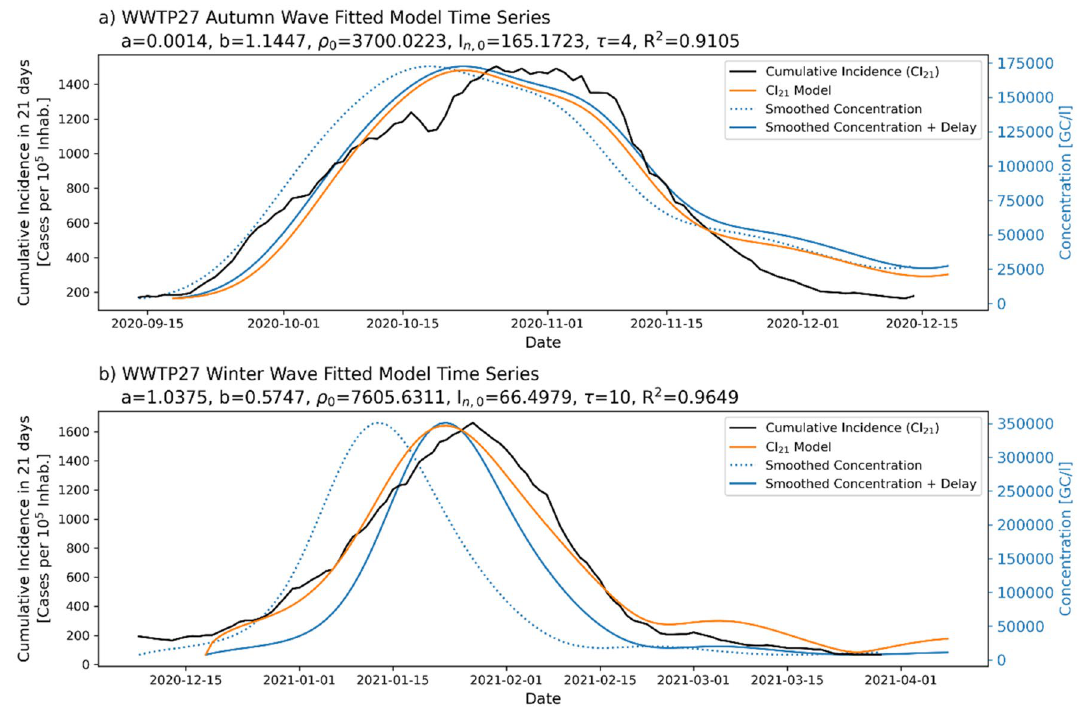
Figure 4. Fitted model for WWTP27 (Tortosa-Roquetes) for the two studied contagion waves. The blue dotted line shows the smoothed concentration, the solid blue line shows the concentration after applying the optimal delay, the black solid line shows the interpolated incidence, and the orange line shows the optimal fitted incidence model.